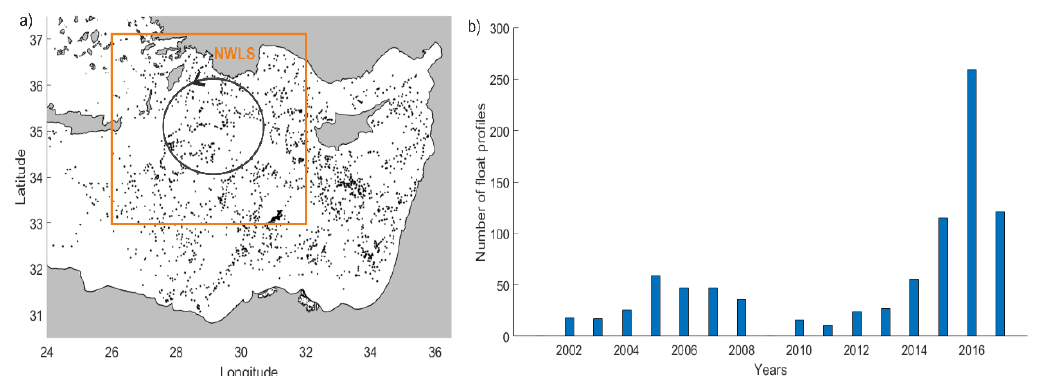
Figure 2. ( a ) Position of the 879 analyzed float profiles for January, February, and March (JFM) 2001 – 2017; Orange rectangle defines the area of study (the NWLS), the black ellipse describes the center of RG. ( b ) Annual distribution of float profiles in the NWLS: JFM 2001 – 2017